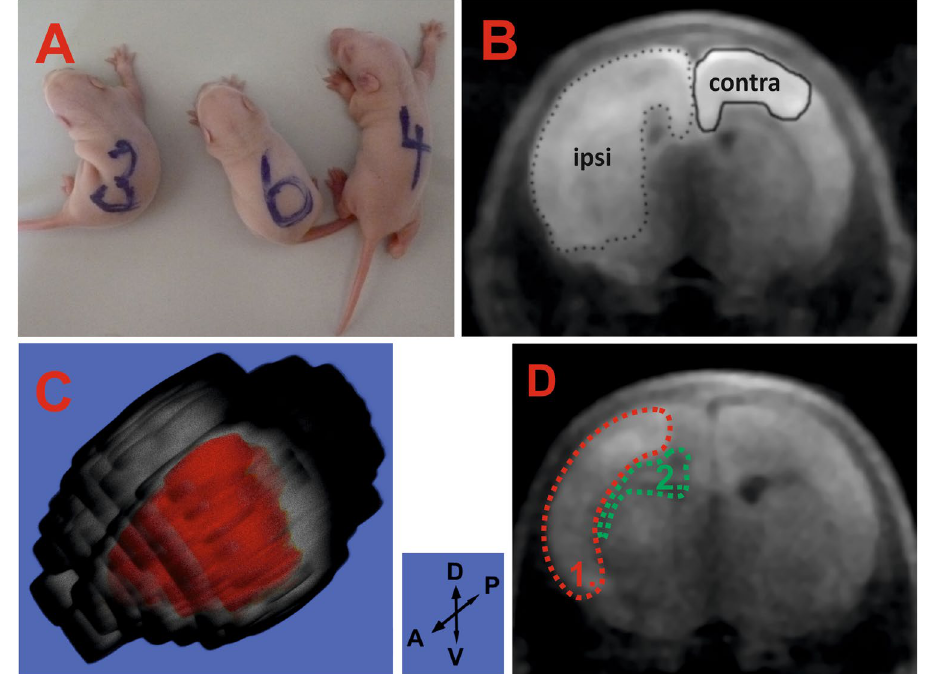
Figure 1. Effects during the acute and subacute stages of HI insult. (A) – insulted pups curved to the left (#3 and 4), while the sham pups did not (#6). (B) – cytotoxic oedema development in the ipsilateral hemisphere (dotted line) and contralateral hemisphere (bold line) was detected immediately after HI insult at the striatal level (pup #16). (C) – 3D image of the brain depicting the extent of the lesion (in red) in the ipsilateral hemisphere (pup #7); D-V and A-P black arrows indicate the dorso-ventral and anterior-posterior directions, respectively. (D) – subacute stage: areas of simultaneously occurring vasogenic and cytotoxic oedema are shown in green and red, respectively (pup